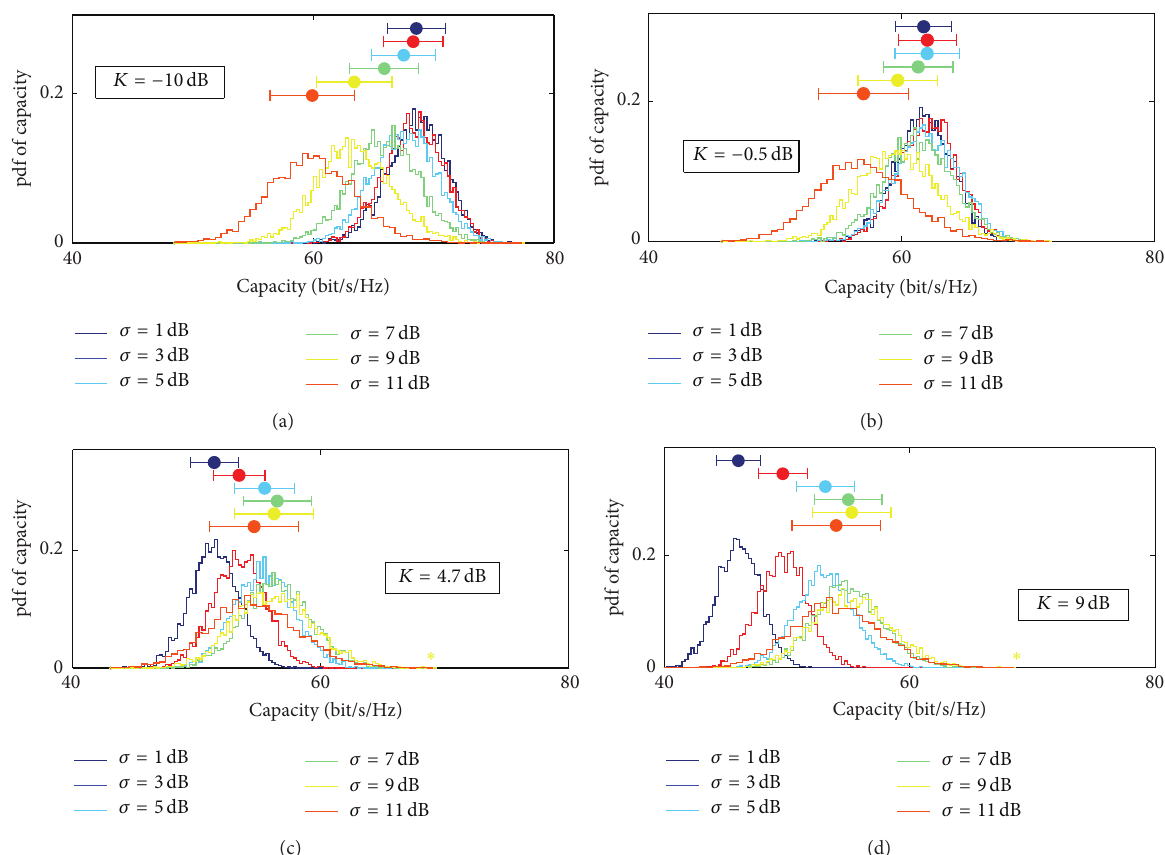
Figure 9: Probability density function of capacity versus capacity for 8 × 8 MIMO system, (a) with SNR = 30 dB and Rician 𝐾 -factor = − 10dB, (b) Rician 𝐾 -factor = − 0.5 dB, (c) Rician 𝐾 -factor = 4.7 dB, and (d) Rician 𝐾 -factor = 9dB.